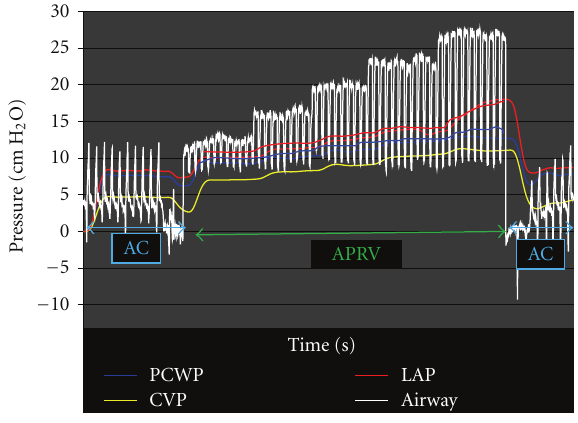
Figure 3: Representation of changes in PCWP and LAP in the same swine model as modes of ventilation change from AC to APRV and back to AC with return of both PCWP and LAP to